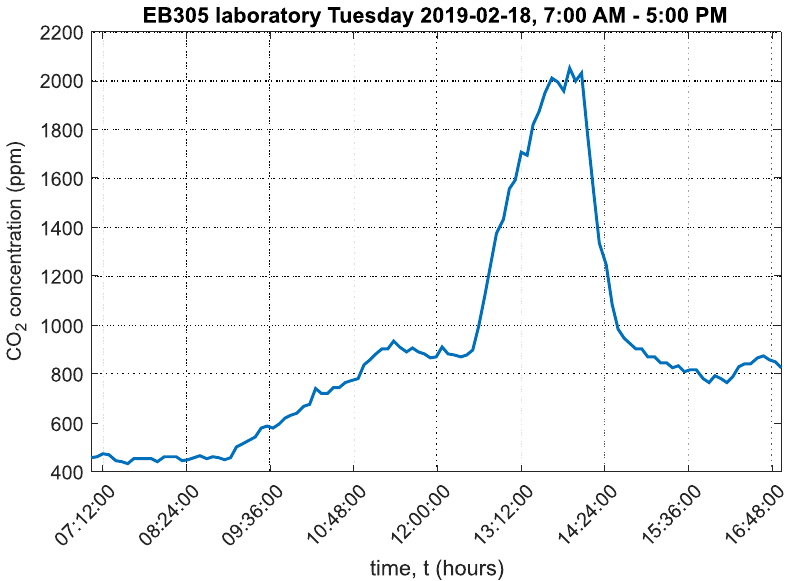
Figure 10. Graph of carbon dioxide concentration in laboratory EB305,